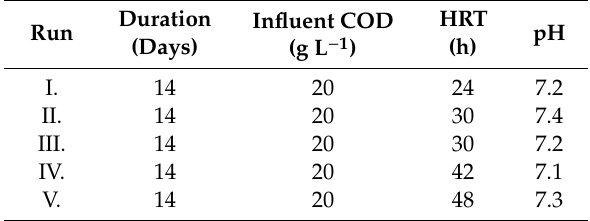
Table 3. Operational condition for monitoring HUASB reactor under continuous mode. HRT = hydraulic retention